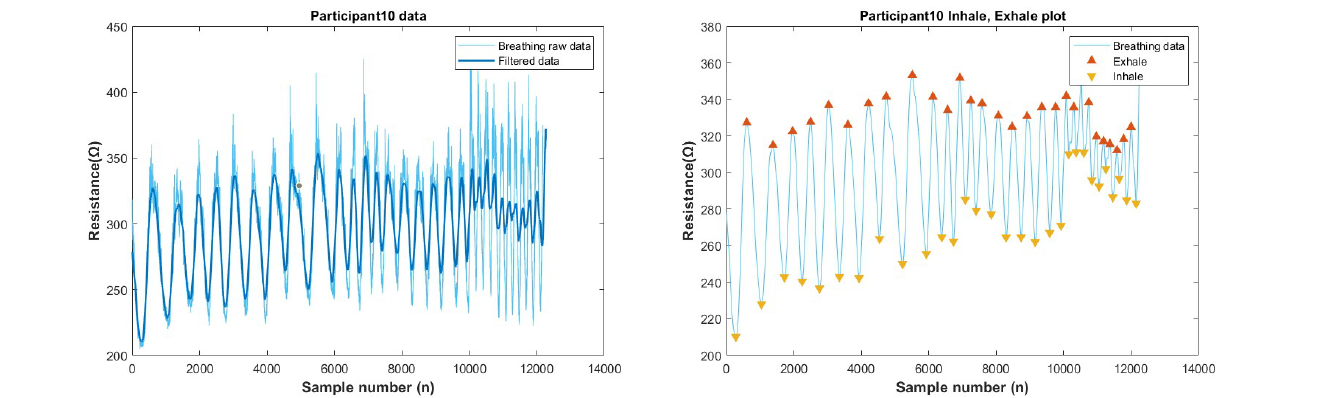
Figure A25. Breathing Test data of Participant